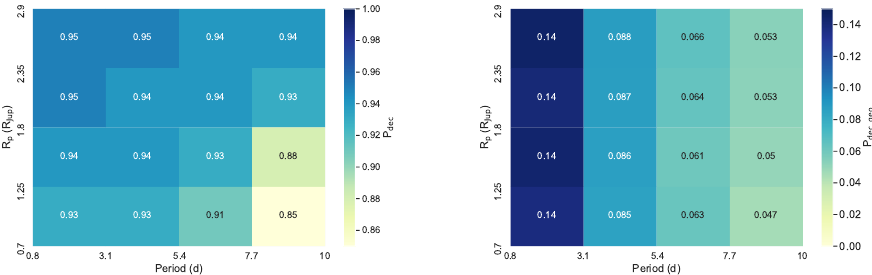
Figure 10. ( Left panel ): The average sensitivity of our detection pipeline as a function of orbital period and planet radius based on a injection-recovery simulation. ( Right panel ): The average search completeness map after accounting for the transit probability. Darker colors indicate higher numerical